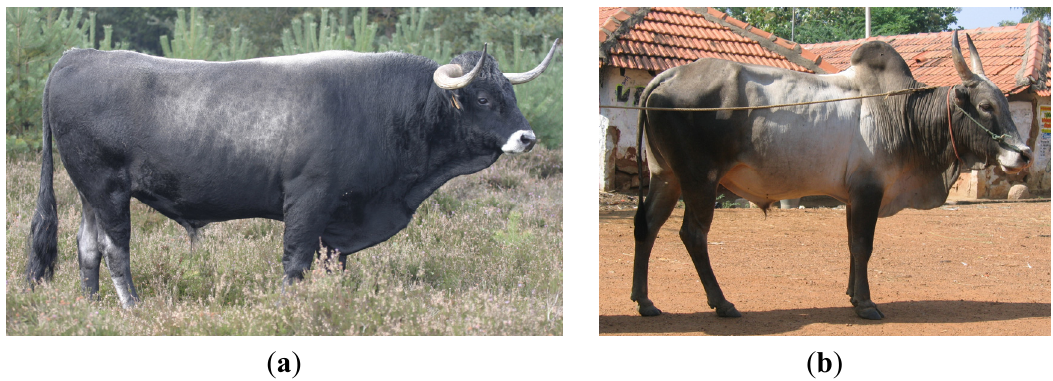
Figure 1. Major domestic cattle species: ( a ) Spanish Tudanca taurine and ( b ) Pullikulam zebu bull (photographs by Marleen Felius and Anno Fokkinga, 2008, 2005).